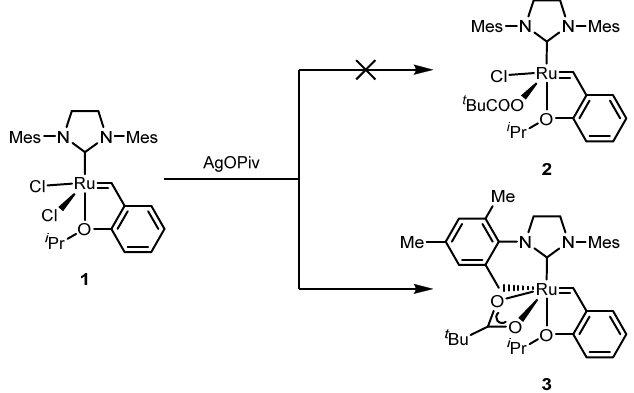
Figure 2. Surprising C–H activation leading to the initial cyclometalated ruthenium metathesis